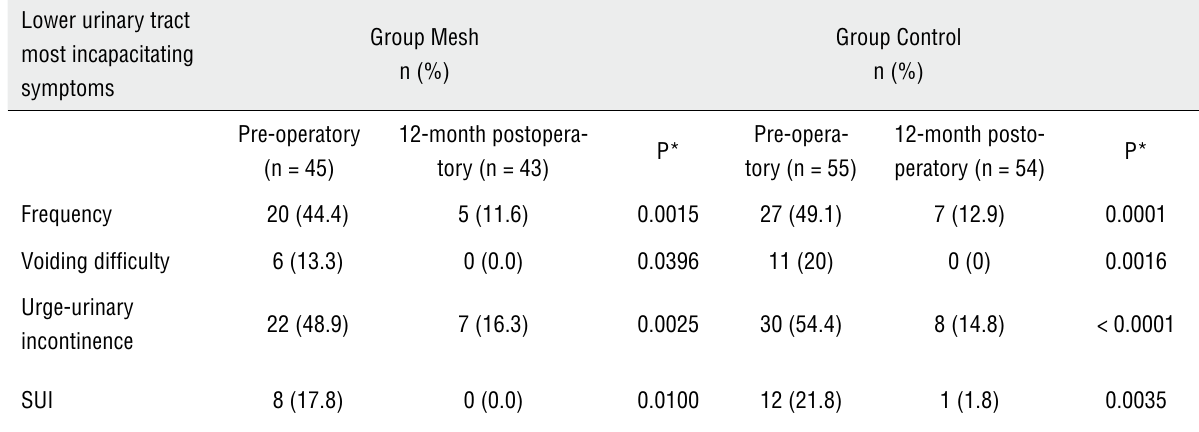
Table 4 – Surgery effect on the most incapacitating lower urinary tract symptoms comparing pre- and postoperatory periods after 12 months of Mesh and Control groups. Values expressed as frequency and percentage